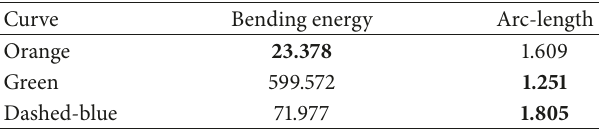
Table 2: Comparison of the bending energies and arc-lengths of the 3 important interpolants shown in Figure